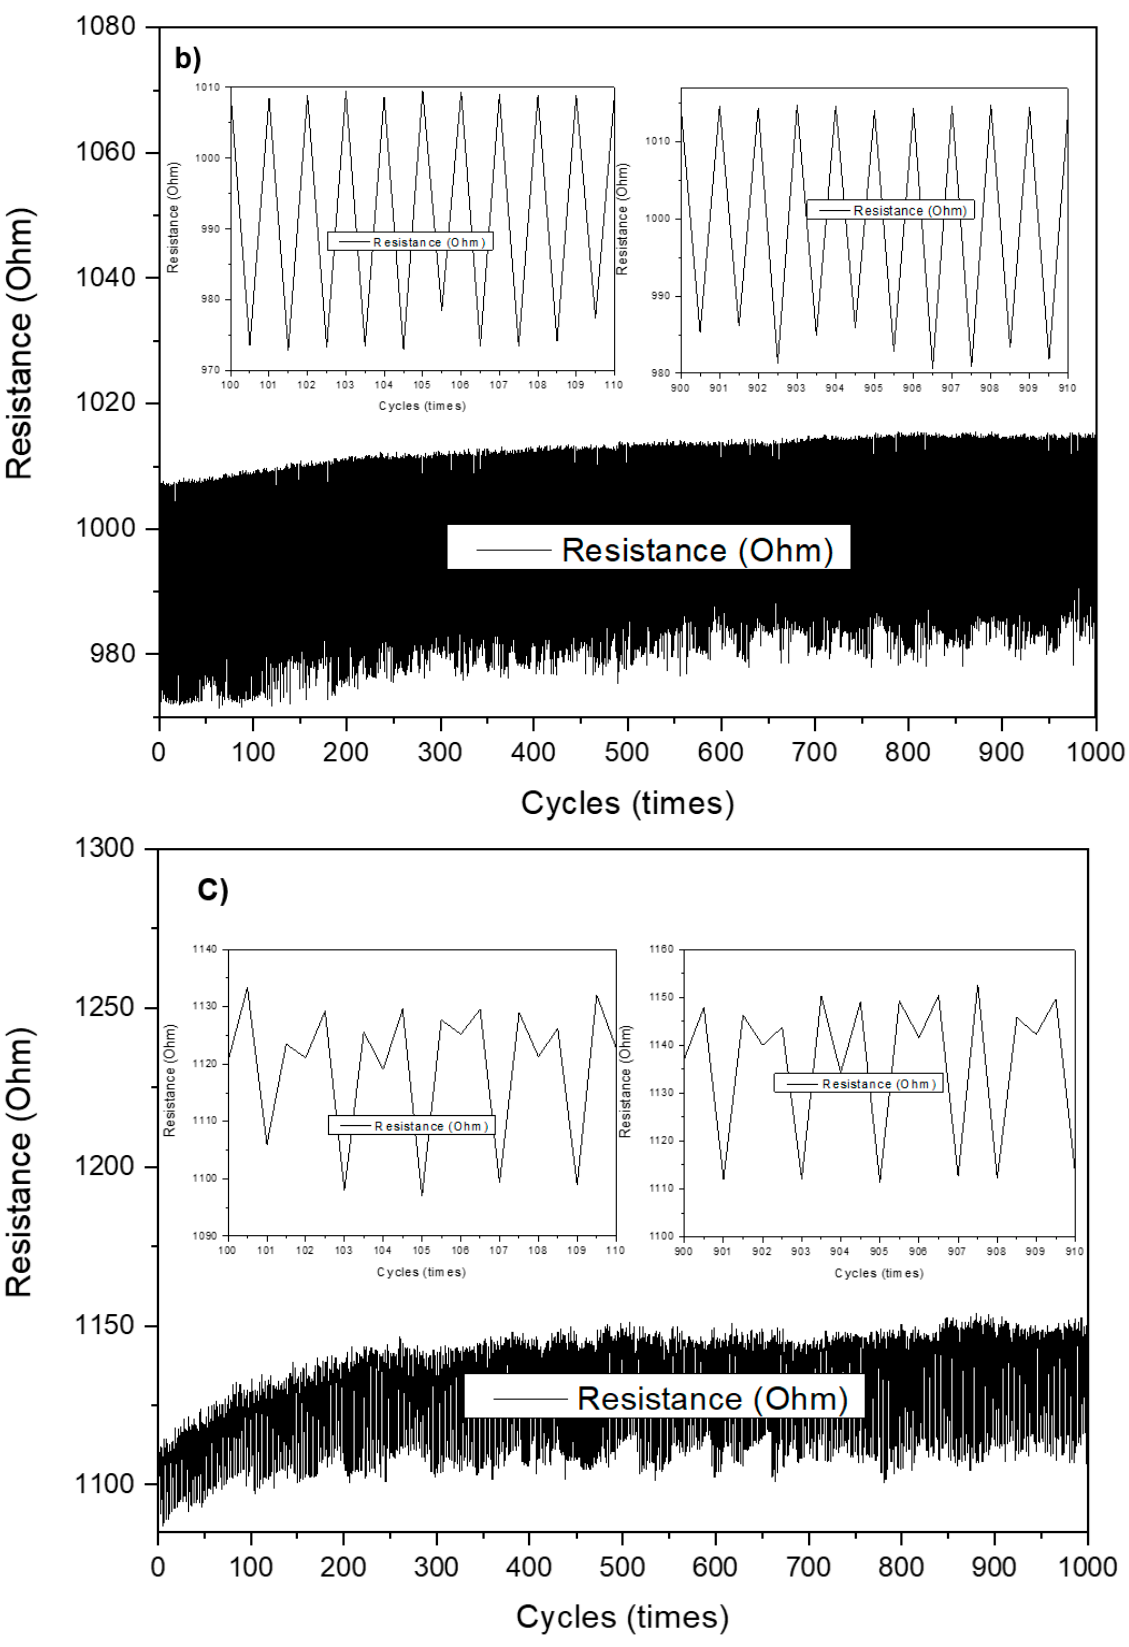
Figure 9. 1000-times cyclic test results for ( a ) single-layer, ( b ) double-layer, and ( c ) quadruple-layer sensors.